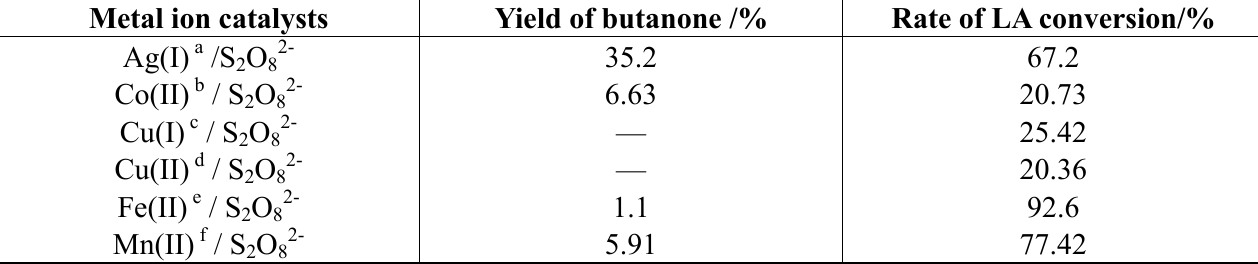
Table 2. Effect of metal ions on the yield of butanone and the rate of LA conversion in S O 82 − reaction system (temperature: 100 °C; time: 0.5 h; pH: 2